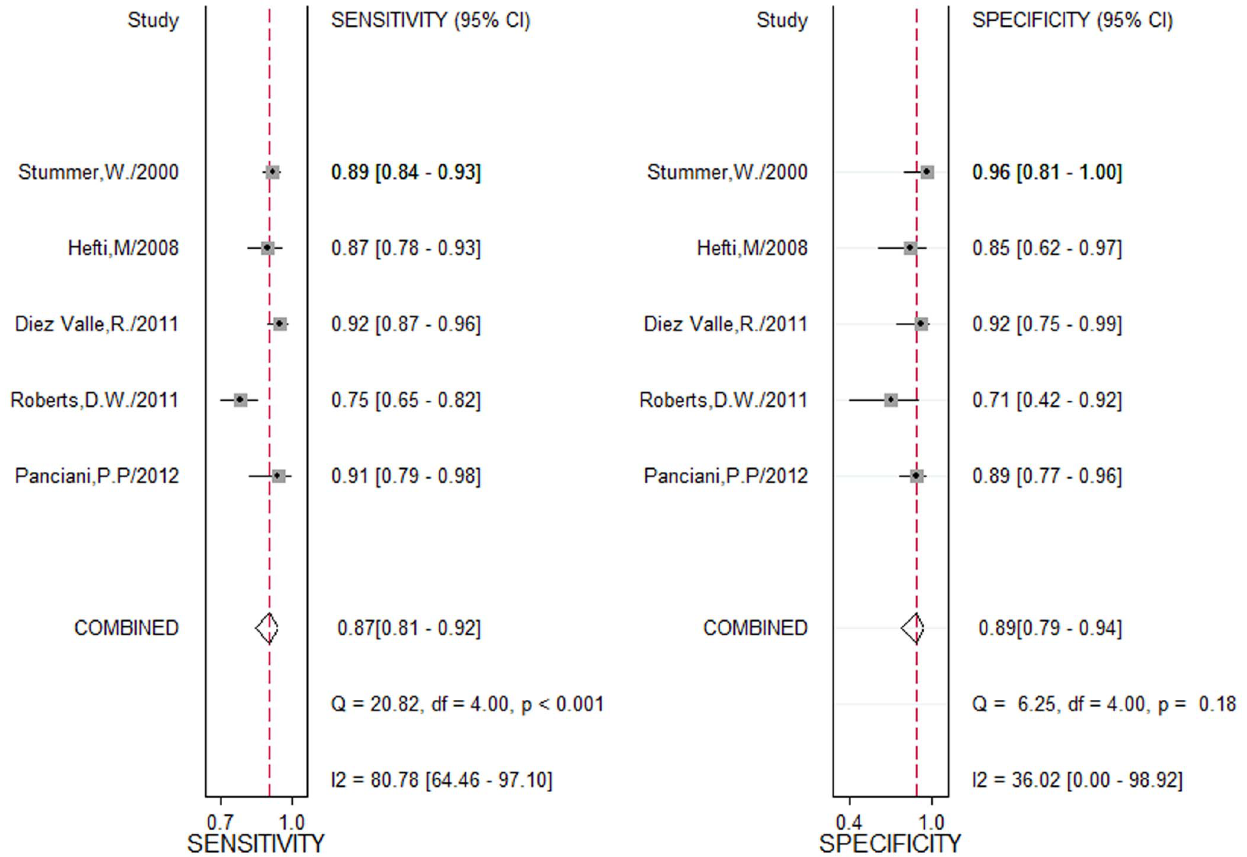
Figure 3. Forest plot for diagnosis of glioblastoma multiforme in studies included in meta-analysis.